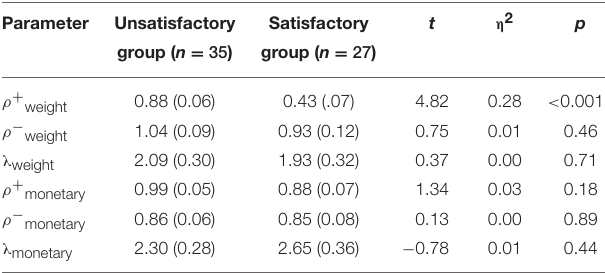
TABLE 1 | Prospect theory model parameters for unsatisfactory and satisfactory